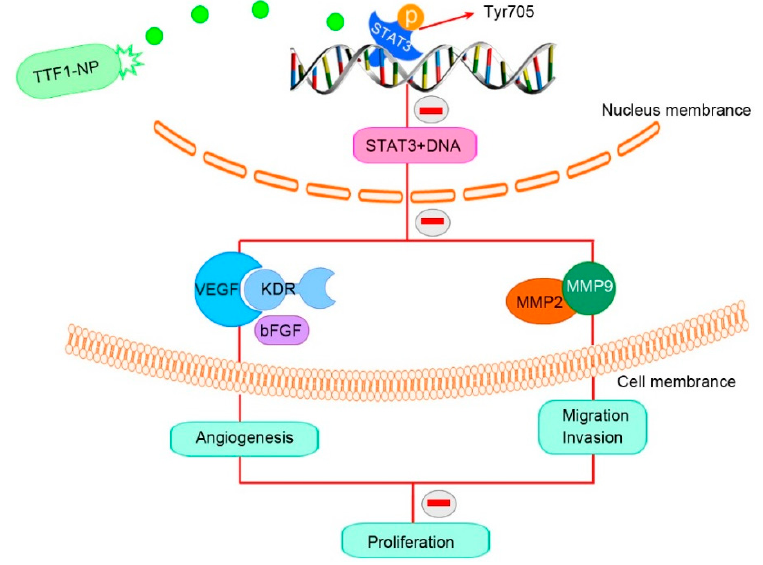
Figure 8. The final effect on angiogenesis and migration, invasion of TTF1-NP on STAT3 in HepG2 cells.